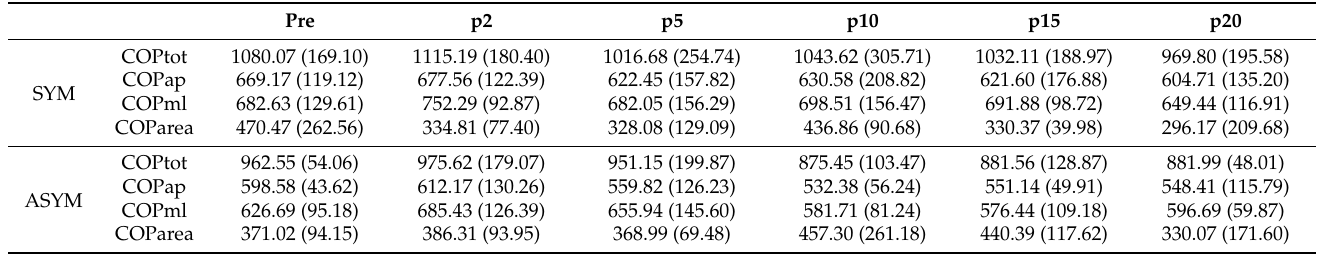
Table 3. COP variables from the ND-leg in the SYM and ASYM subgroups.